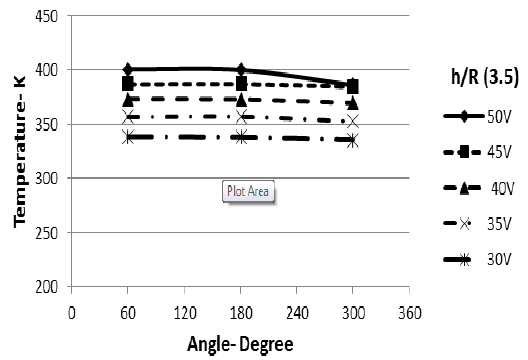
Figure 8. Average face temperature with different voltages at a depth/radius ratio of